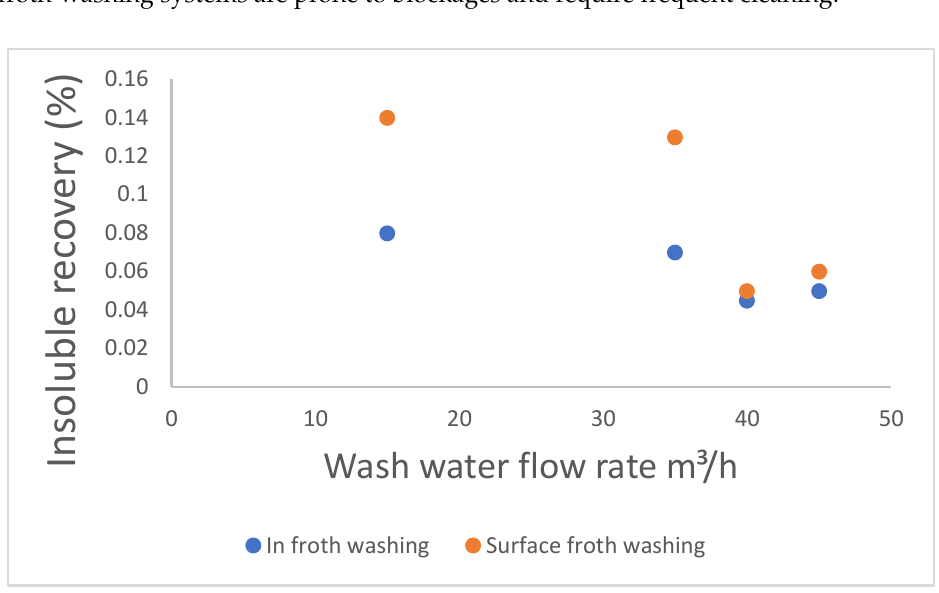
Figure 2. Comparison of insoluble solids ’ recovery rates for internal froth washing and surface froth washing reproduced from [42].